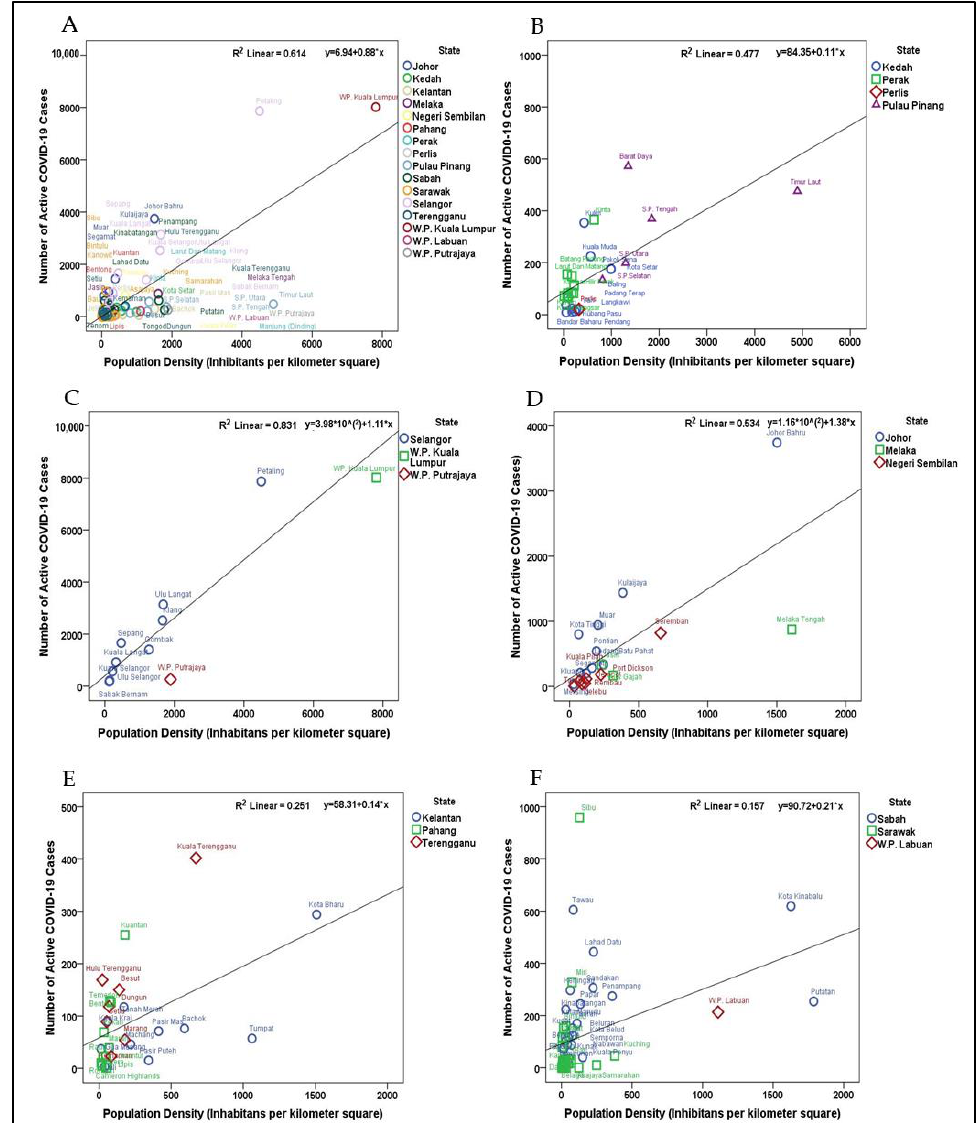
Figure 5. Point cloud population density and COVID-19 cases with model fitted simple regression lines. ( A ) Malaysia R 2 = 0.614; ( B ) Northern region R 2 = 0.477; ( C ) Central region R 2 = 0.831; ( D ) Southern region R 2 = 0.534; ( E ) East Coast region R 2 = 0.251; ( F ) East Malaysia R 2 =